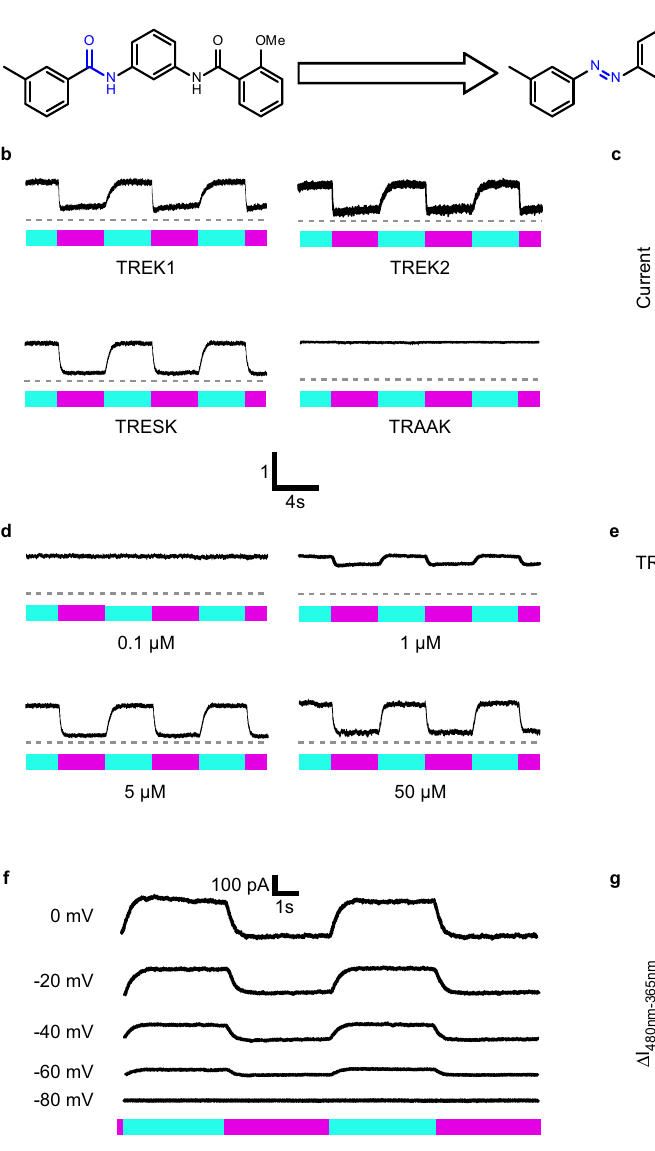
Fig. 1| LAKIselectivelyphoto-controlsTREK1, TREK2and TRESKchannelsina heterologous system. a Design of LAKI from ML365 and photoisomerization of LAKI upon alternating illumination at 480nm (blue) and 365nm (magenta). b Normalized whole-cell current recording elicited at − 60mV from HEK293T cells expressing TREK1, TREK2, TRESK and TRAAK in the presence of LAKI (5 µ M) upon alternating illumination at 480nm (blue) and 365nm (magenta). c Bar graph summarizingthecurrentinhibition(%)ofTREK1,TREK2,TRESK,TASK1,TASK3and TRAAK at − 60mV. For each channel, n was obtained from one experiment. Sta- tistical signi fi cance was determined by QuasiBinomial GLM followed by Dunnett ’ s post-test versus TASK1 (*** p <0.001). d Normalized whole-cell current recordings elicitedat − 60mVfromHEK293TcellsexpressingTRESKinthepresenceofseveral